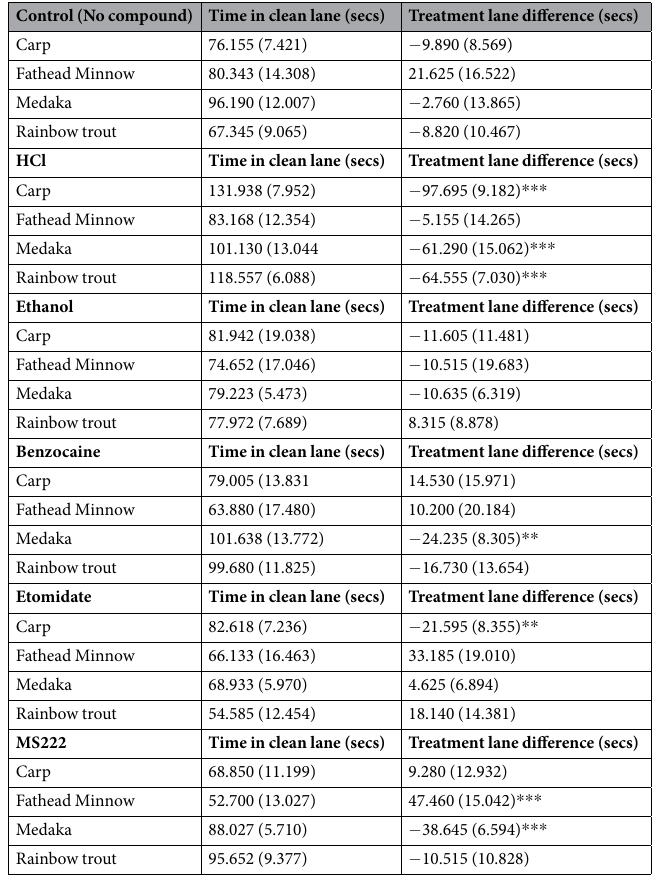
Table 1. Summary of MLwiN estimates ( ± SEM) of the effects for each of the anaesthetic agents in dilution water versus exposure for the response variable Time. Statistical significance is denoted by * P < 0.05, ** P < 0.01, *** P <